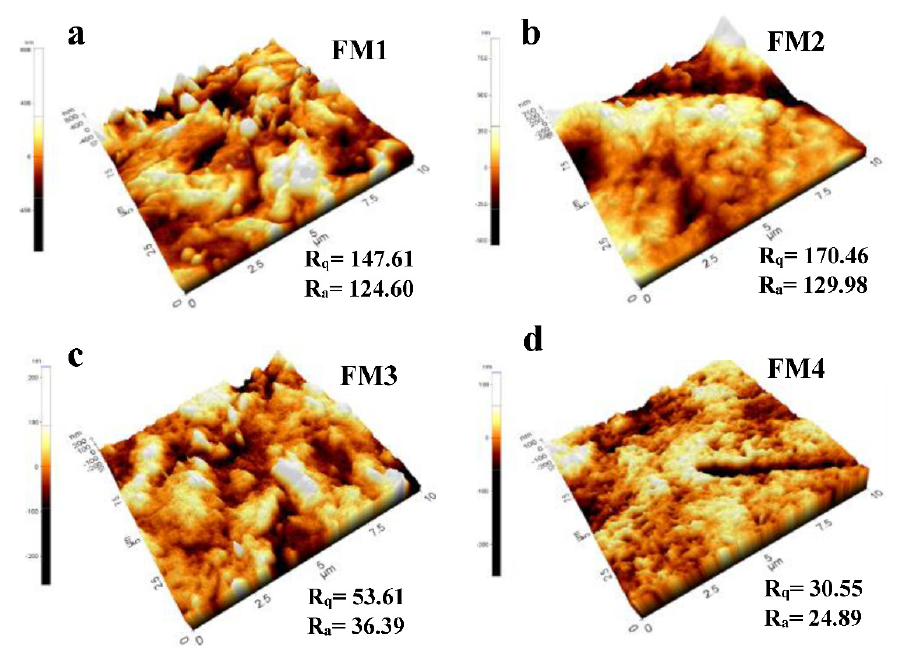
Figure 11. AFM top surface images with average membrane roughness values (nm) for different compositions of selected PVDF-PAC membranes: ( a – d ) for (FM1 to FM4). For membrane permeability analysis, the impact of PAC addition to membrane per- meability, in terms of porosity and average pore size, were evaluated for the produced PVDF membranes. As presented in Table 6, the porosity and average pore size of the fab- ricated PVDF membranes incorporated with PAC were higher than the other membranes tion”, and the highest mean values of porosity and average pore size were achieved by FM2 membrane at the values 77.48% and 24.43 µm, respectively. On the other hand, the lowest values of the same corresponding permeability parameters were found using membrane FM4 at 48.38% and 12.15 µm, respectively. These findings agreed with the above morphological results. Table 6. Permeability measurements for selected fabricated PVDF-PAC membranes. Membrane